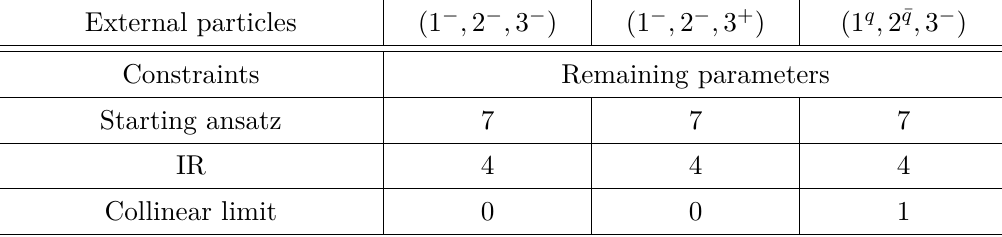
Table 2. Bootstrap for one-loop form factors of tr( F 2 ) .